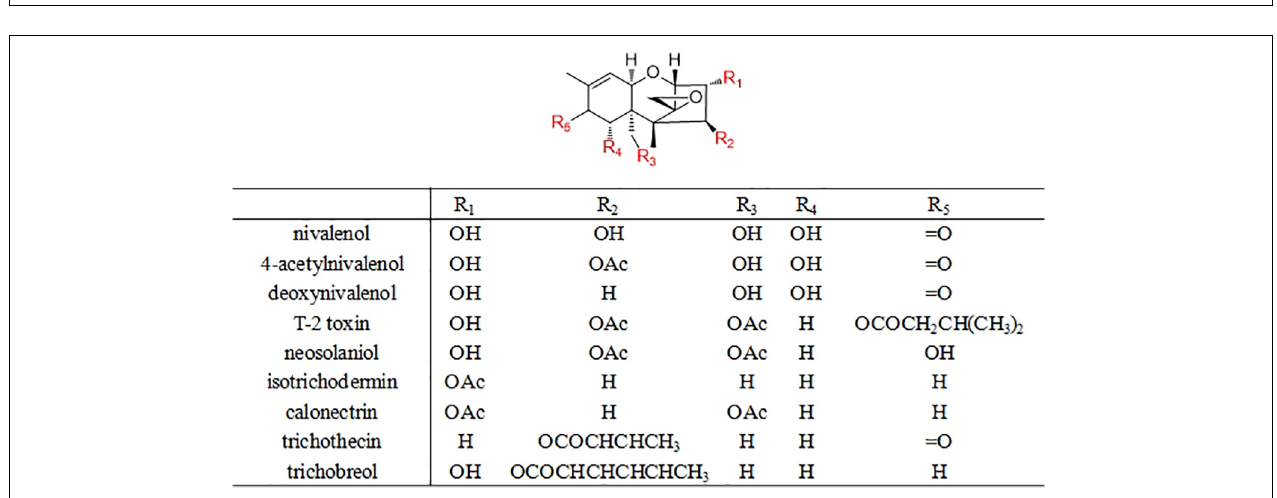
FIGURE 8 | Selected structures of naturally sourced griseofulvin derivatives and synthetic analogs.